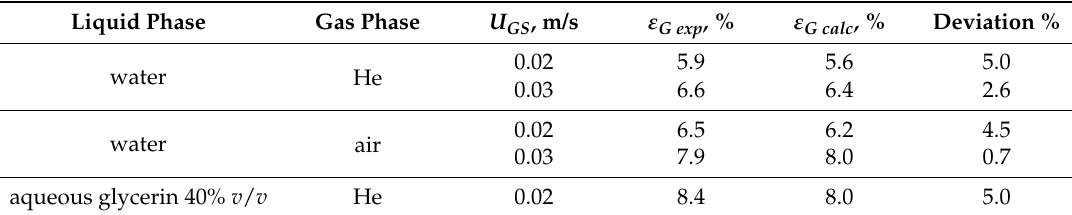
Table 7. Comparison of typical simulation results with the experimental data.